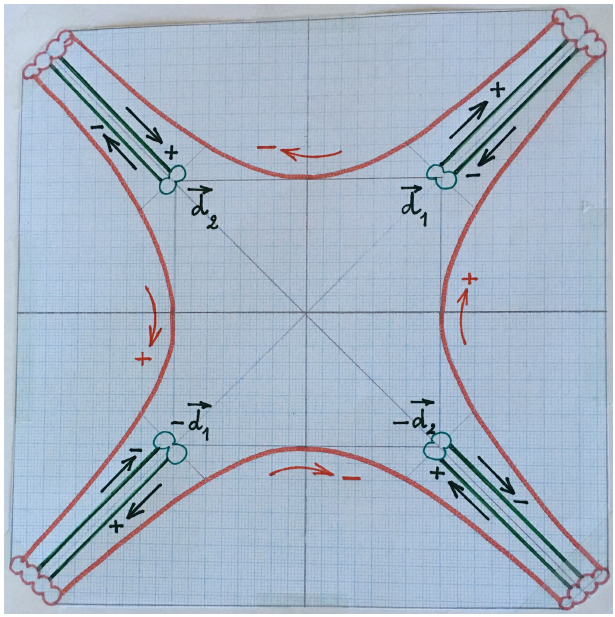
Figure 10. The central angles basic curve.